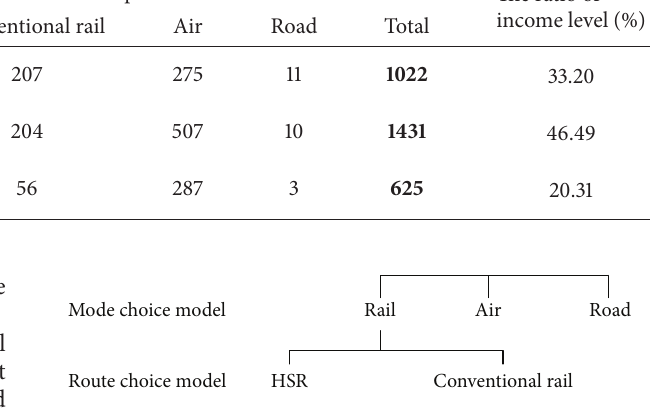
Figure 1: Structure of nested mode/route choice